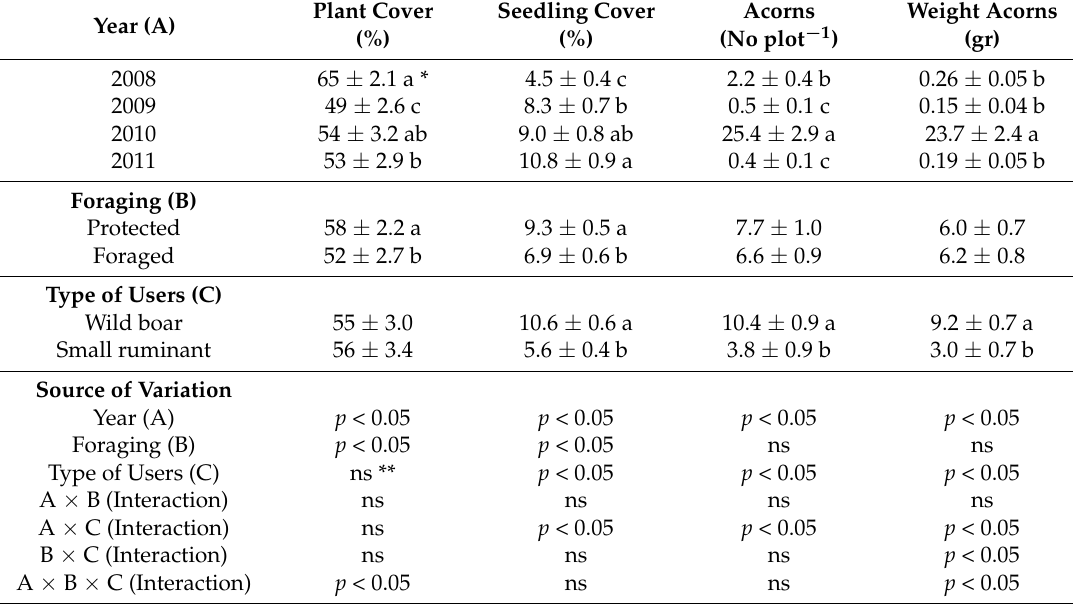
Table 3. The effect of year, foraging, and type of users on plant cover, seedling cover, number of acorns and weight of acorns (mean ±